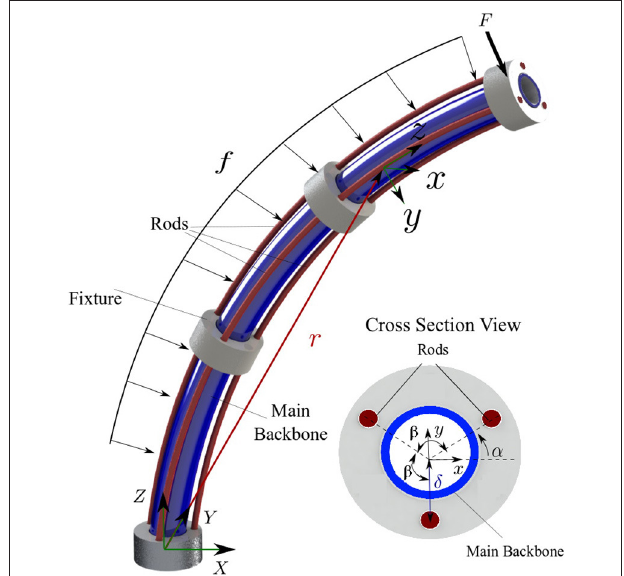
FIGURE 3 | A schematic of the continuum robot with one bent segment. The main backbone is modelled as a Cosserat rod under external point force ( F ) and distributed load ( f ). The cross section view shows the position of the rods with respect to the main backbone.